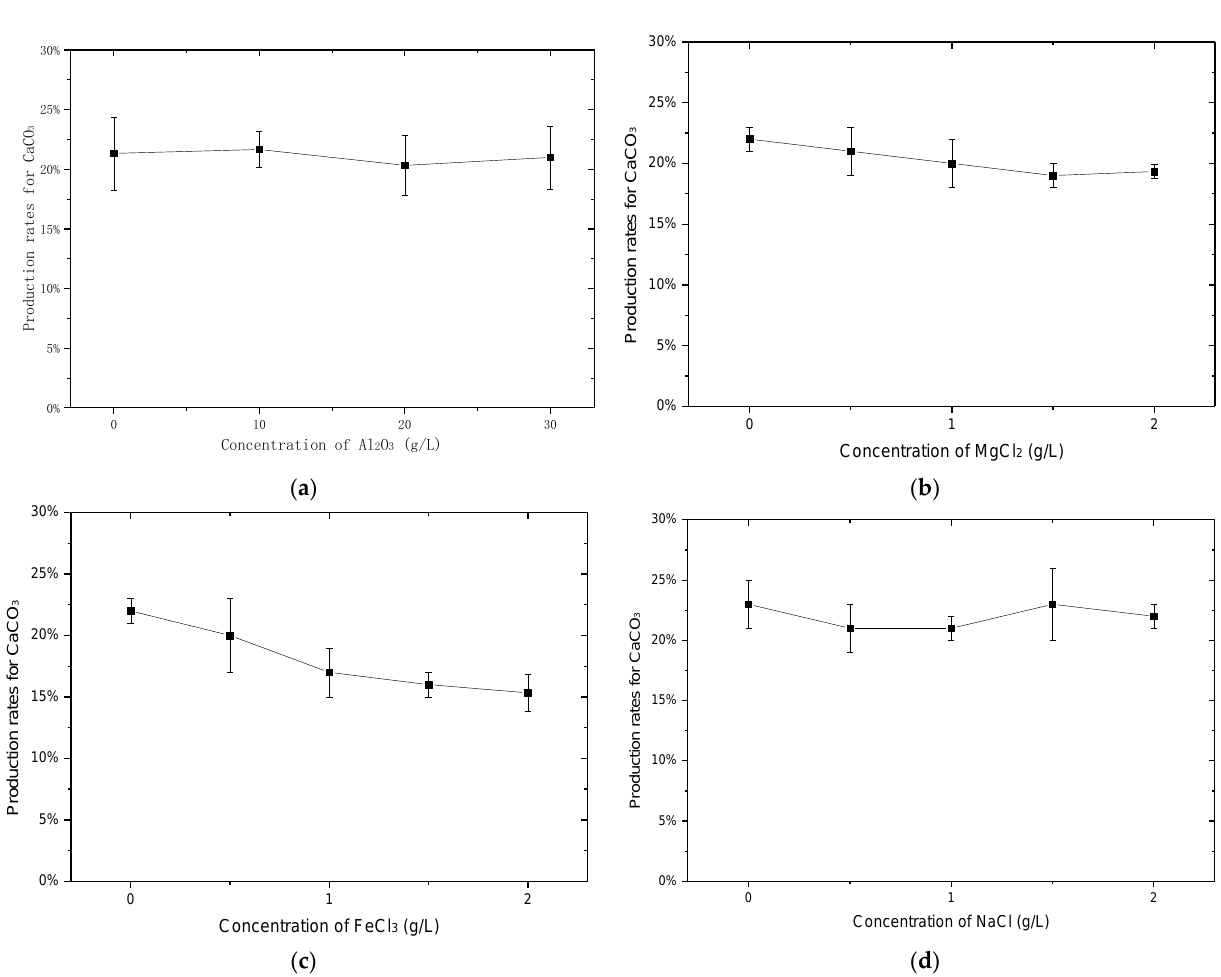
Figure 2. Effects of different compositions in kaolin clay on the production rate for calcium carbonate: ( a ) Al 2 O 3 ; ( b ) MgCl 2 ; ( c ) FeCl 3 ; ( d ) NaCl.